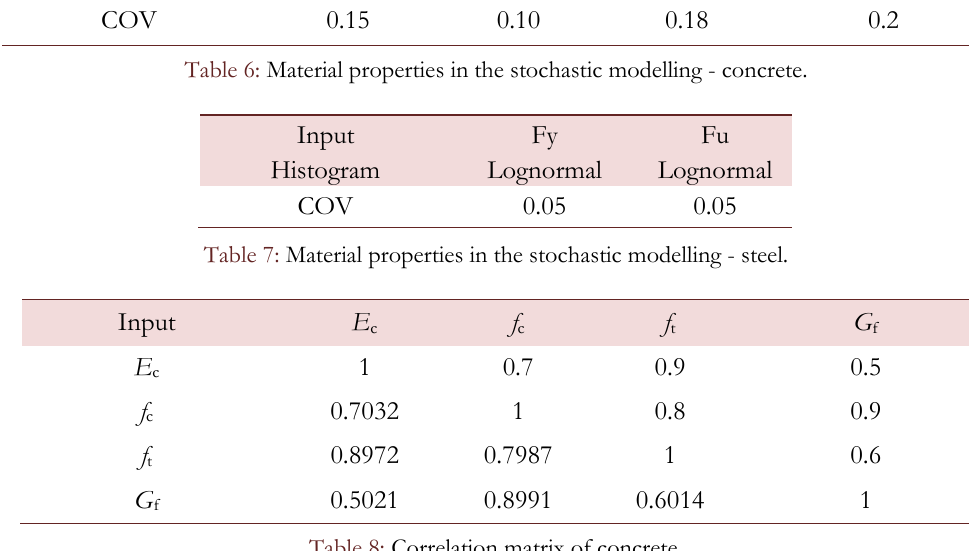
Table 8: Correlation matrix of concrete.